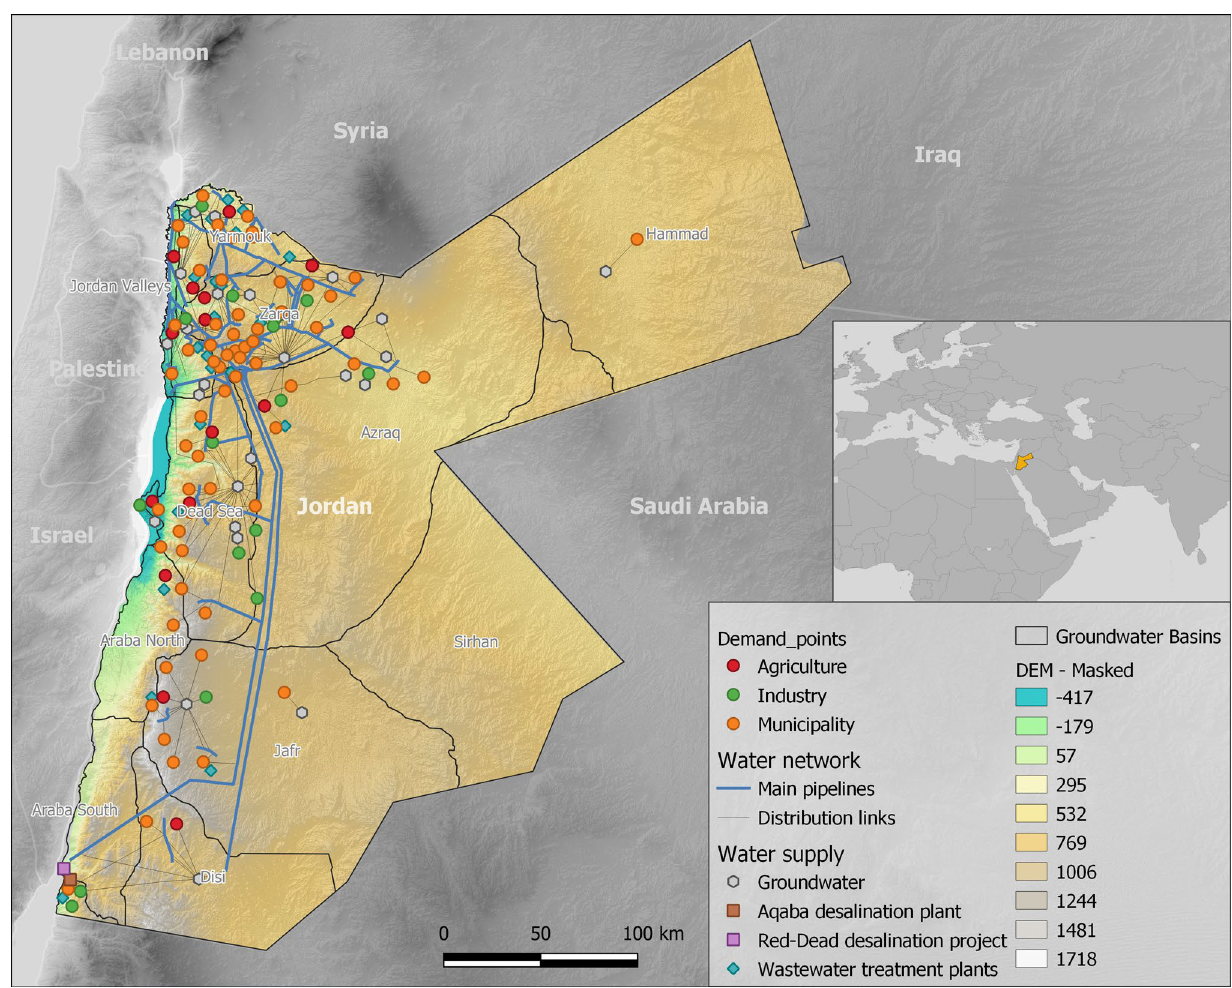
Fig. 2 WEAP model schematic—representation of the water system in